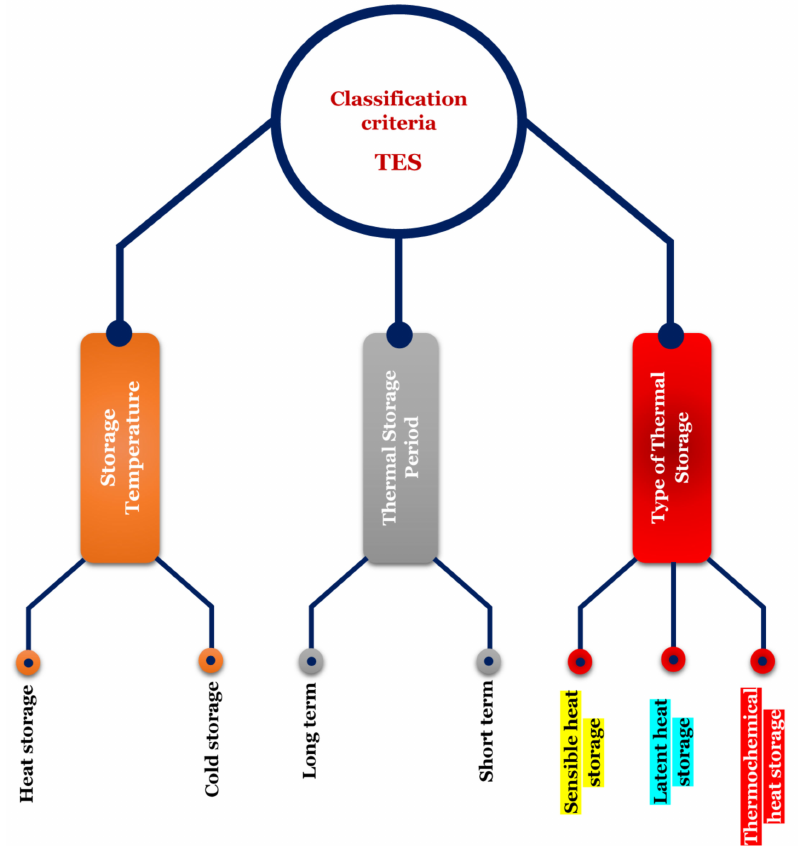
Figure 2. Classification of thermal energy storage